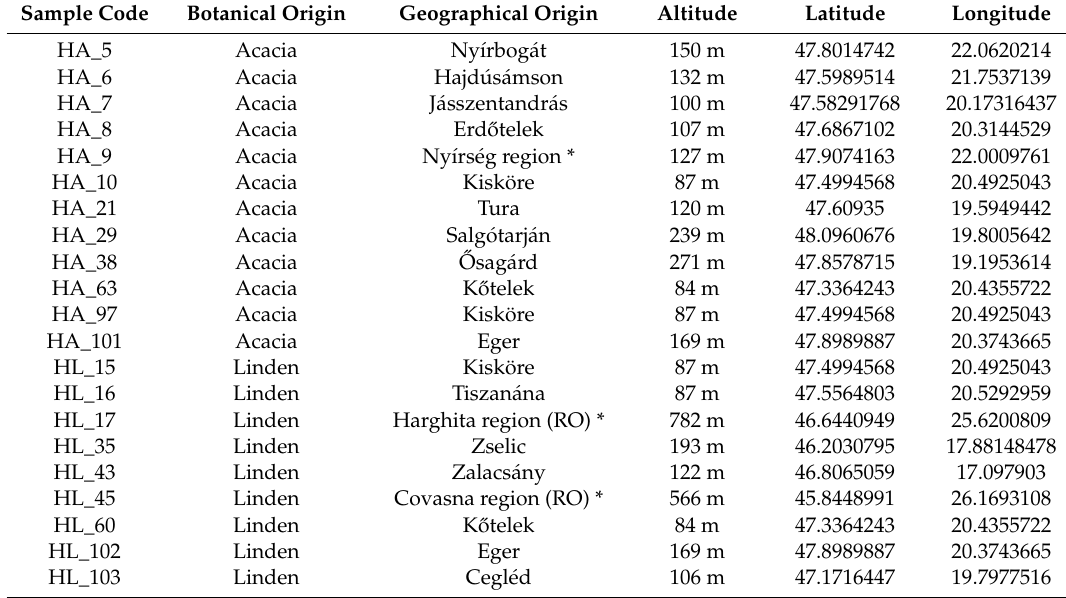
Table 1. Botanical and geographical origins of authentic honey